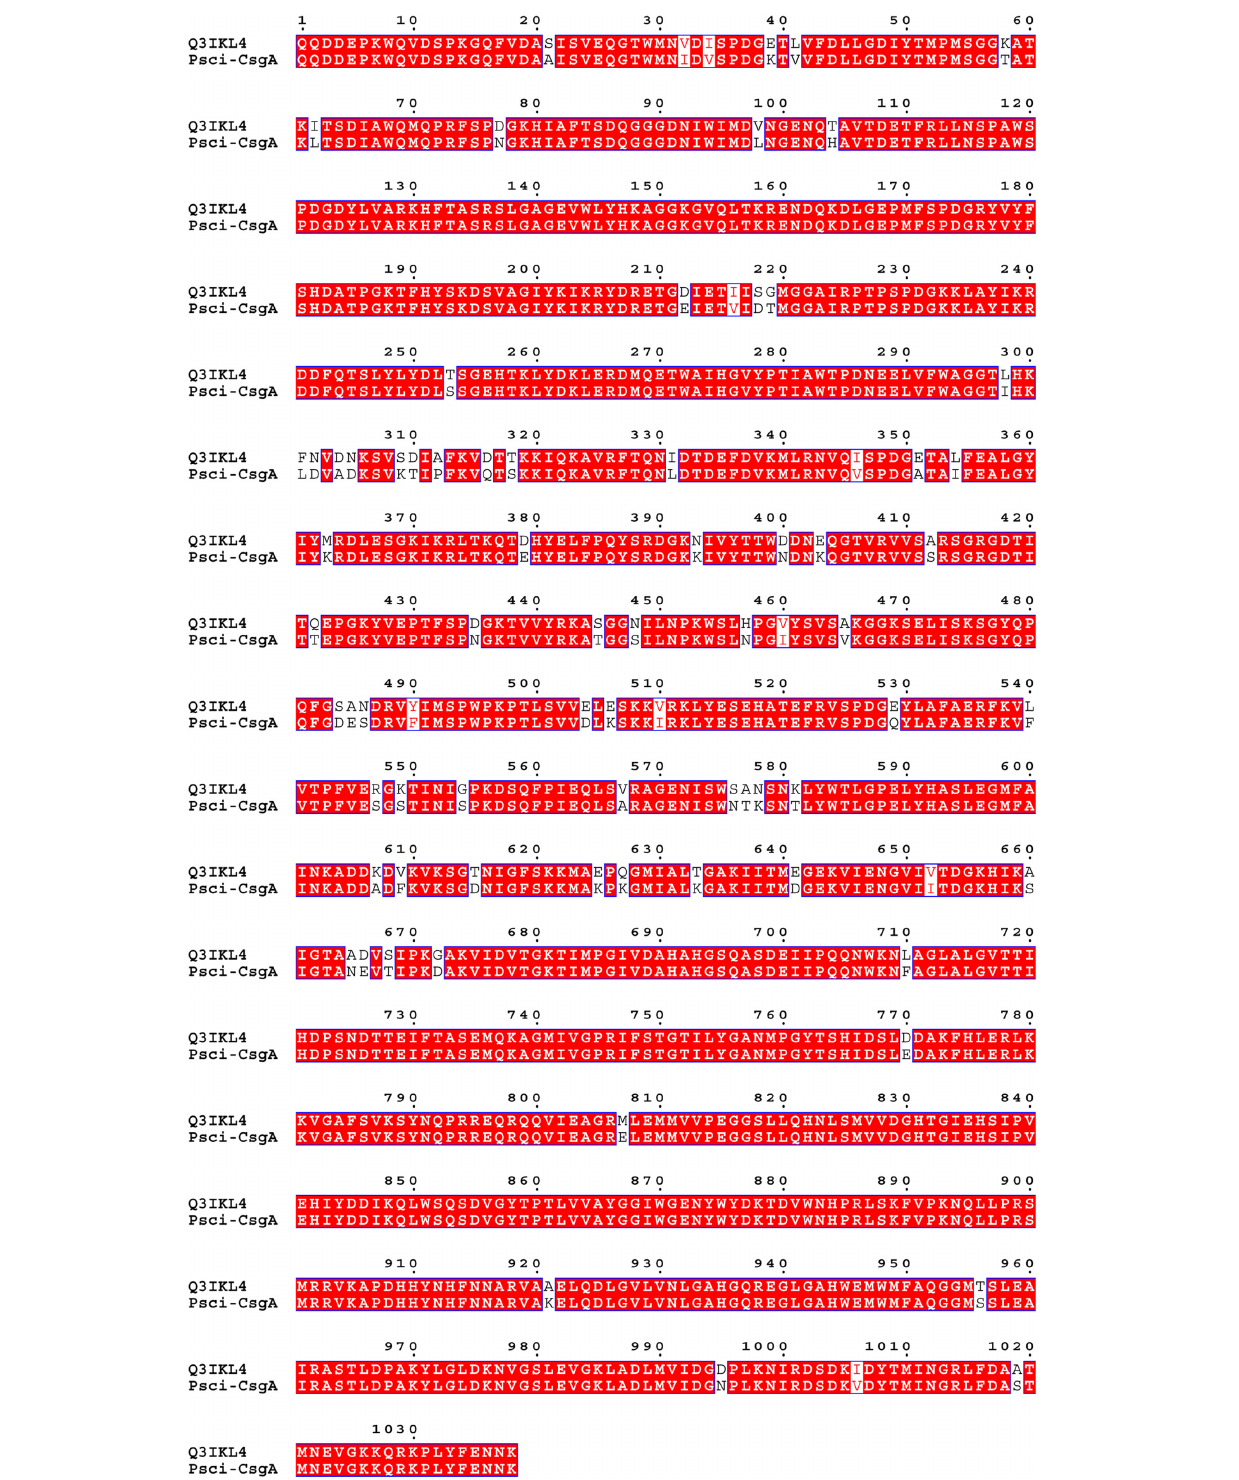
Frontiers in Chemistry | Chemical Biology August 2014 | Volume 2 | Article 67 |